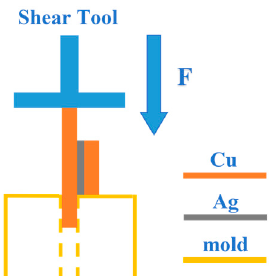
Figure 3. Schematic diagram of shear strength measurement of sandwiched sample.